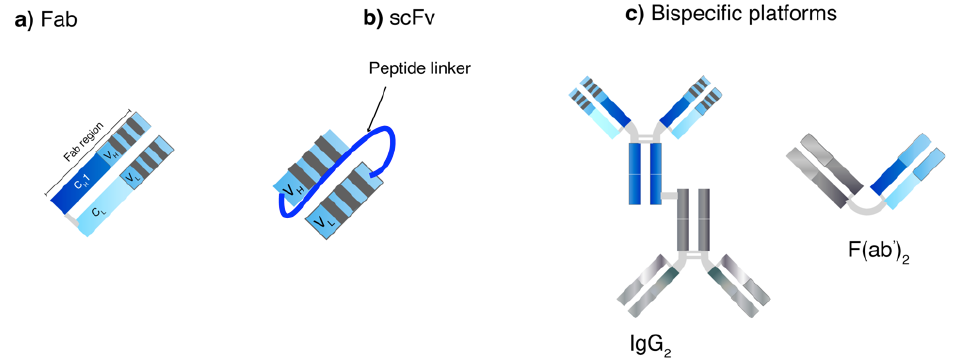
Figure 3. Small-mAb derived fragment technologies and next generation mAbs. ( a ) Recombinant fragment antigen-binding (Fab), ( b ) Single-chain variable fragment (scFv) and ( c ) bispecific mAb platforms. The latter can comprise two covalently linked heterogenous IgG (IgG 2 ) or heterogenous Fab domains (F(ab’) 2 ).